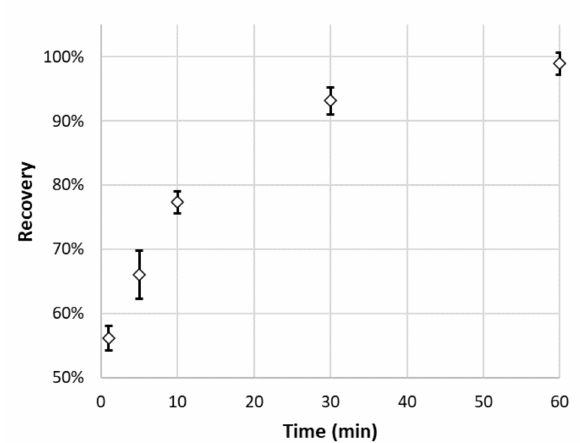
Figure 5. The impact of desorption time on DNA-20 oligonucleotide recovery from MNP-Ac (oligonu- cleotide sequence is provided in Table 1, MNP-Ac adsorbent structure on Figure 2, and experimental conditions in Section 2.4). Abbreviations: OGN—oligonucleotide.